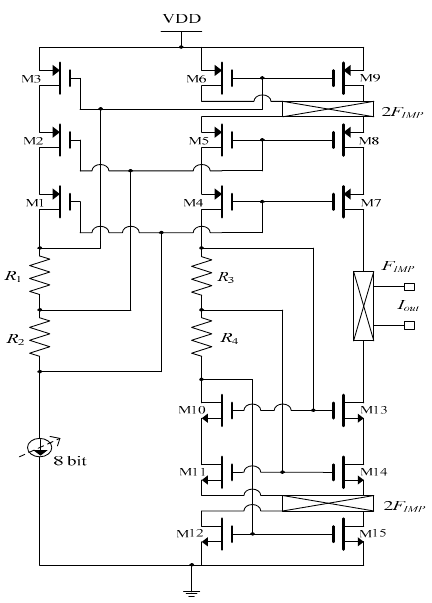
Figure 3. Circuit schematic of triple cascode current driver [9].